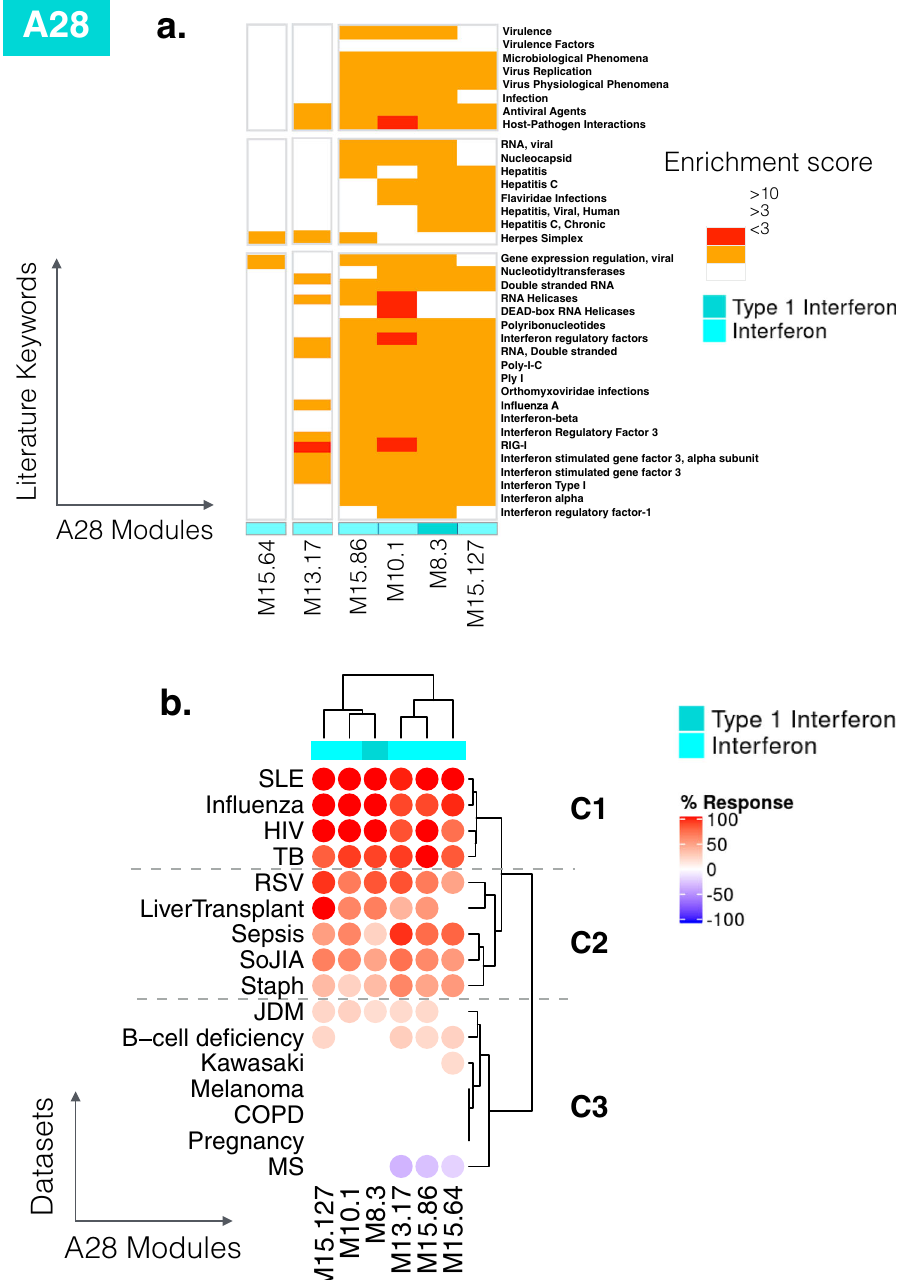
Fig. 8 Literature pro fi les and patterns of changes in abundance across reference datasets for the modules comprising aggregate A28. a Functional annotation by literature pro fi ling. A. Portion of a heatmap comprising 382 modules organized as columns, and literature terms organized as rows. The six modules shown are associated with the consensus annotation “ Interferon ” or “ Type 1 Interferon ” . The clusters of keywords associated with those modules are consistent with this annotation and provide added granularity to the module repertoire for functional pro fi ling and interpretation. b Changes in abundance across 16 reference datasets. The heatmap represents the changes in abundance of transcripts constituting the six modules comprising aggregate A28 (columns). The modules are functionally associated with interferon responses. The 16 reference datasets are arranged as rows corresponding to different health states. The columns and rows are arranged by hierarchical clustering. The heatmaps can be accessed and exported for all 16 datasets and 38 module aggregates using the web application: https://drinchai.shinyapps.io/BloodGen3Module/ (under the “ MODULES X STUDIES ”